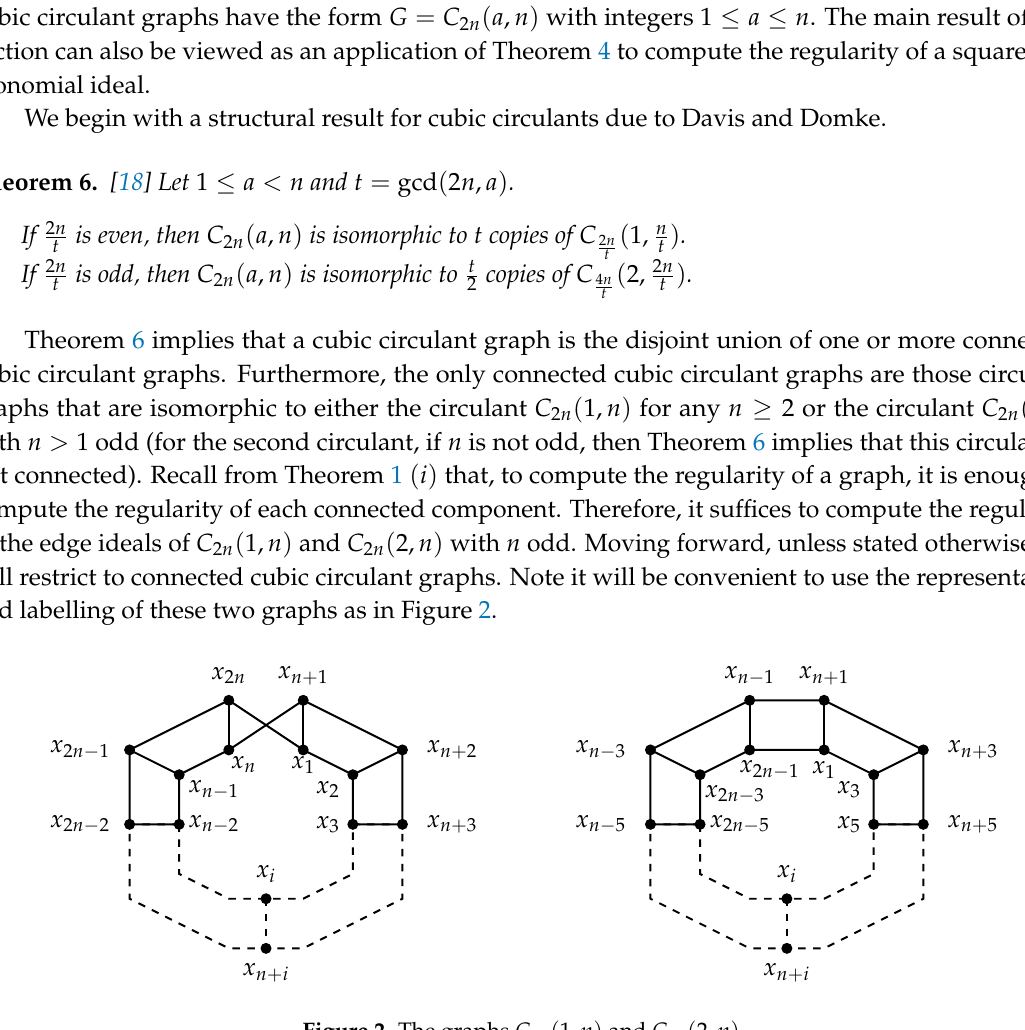
Figure 2. The graphs C 2 n ( 1, n ) and C 2 n ( 2, n )